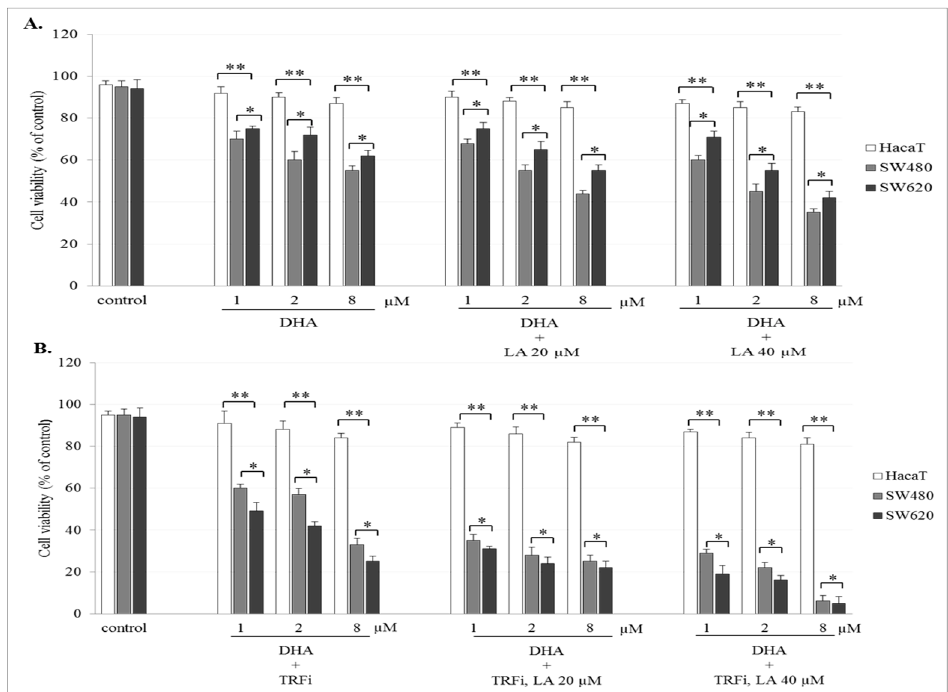
Figure 3. Effect of DHA alone, DHA with LA addition ( A ), DHA–TRFi alone and DHA-TRFi with LA addition ( B ) on viability of SW480, SW620, and HaCaT cells. Cells were treated for 72 h with various concentrations of tested compounds ART (1, 2, and 8 µM), LA (20 and 40 µM) and TRFi (50 µM). Cells viability was assessed by TB assay. Data are expressed as means ± SD. ** p < 0.001 as compared to control, * p < 0.001 as compared to HaCaT.